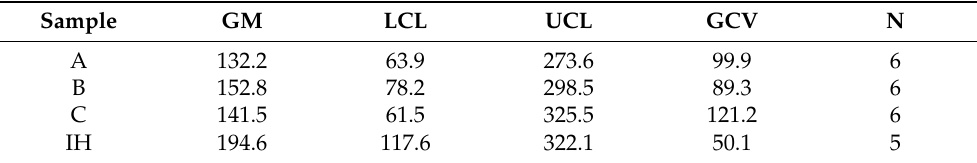
a EC 50 estimates (ng) calculated based on the assumed protein content of 50 µ g for the samples. GM: Geometric mean, LCL: Lower 95% confidence limit, UCL: Upper 95% Confidence limit, GCV: Inter-laboratory geometric coefficient of variation (%), N: Number of